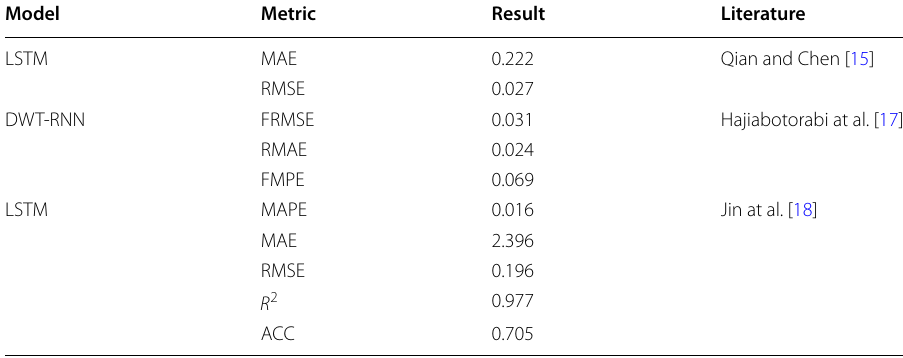
Table 2 Relevant studies using deep learning method Model